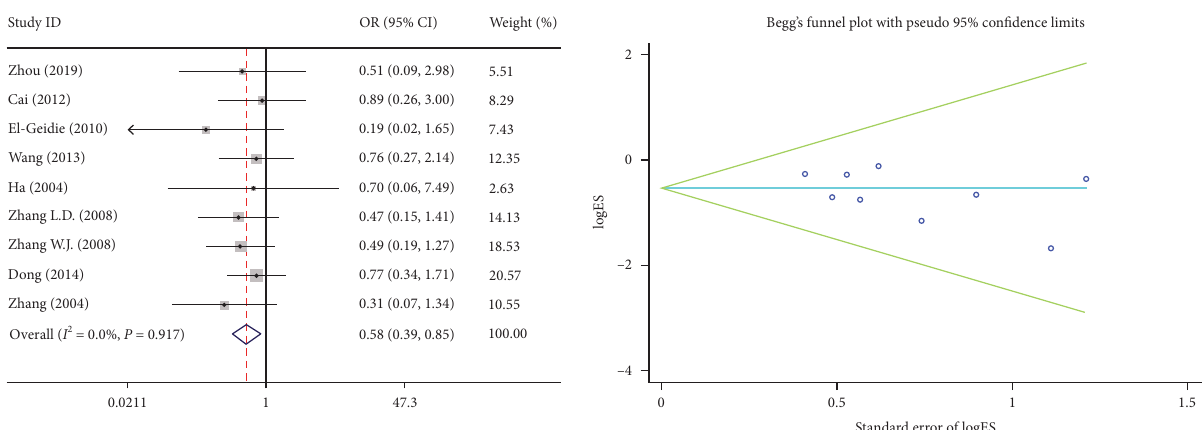
F IGURE 6: Forest plot and funnel plot of the postoperative complications between the primary suture group and the T-tube drainage group.